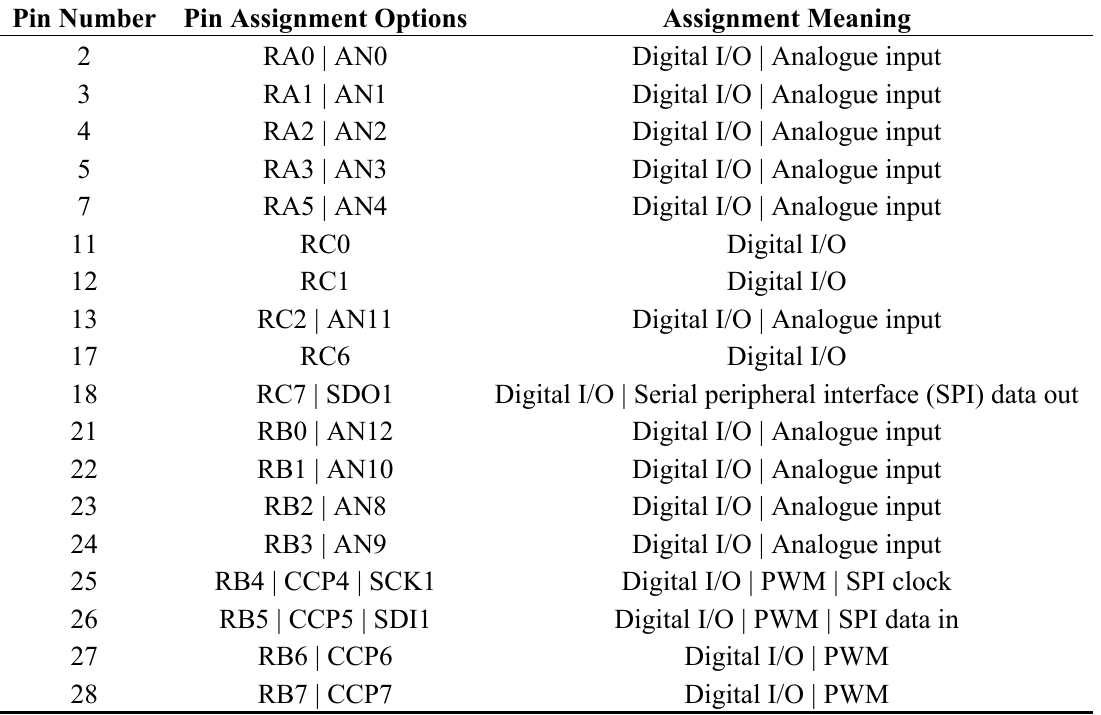
Table 4. Pin assignment options in current version of firmware.